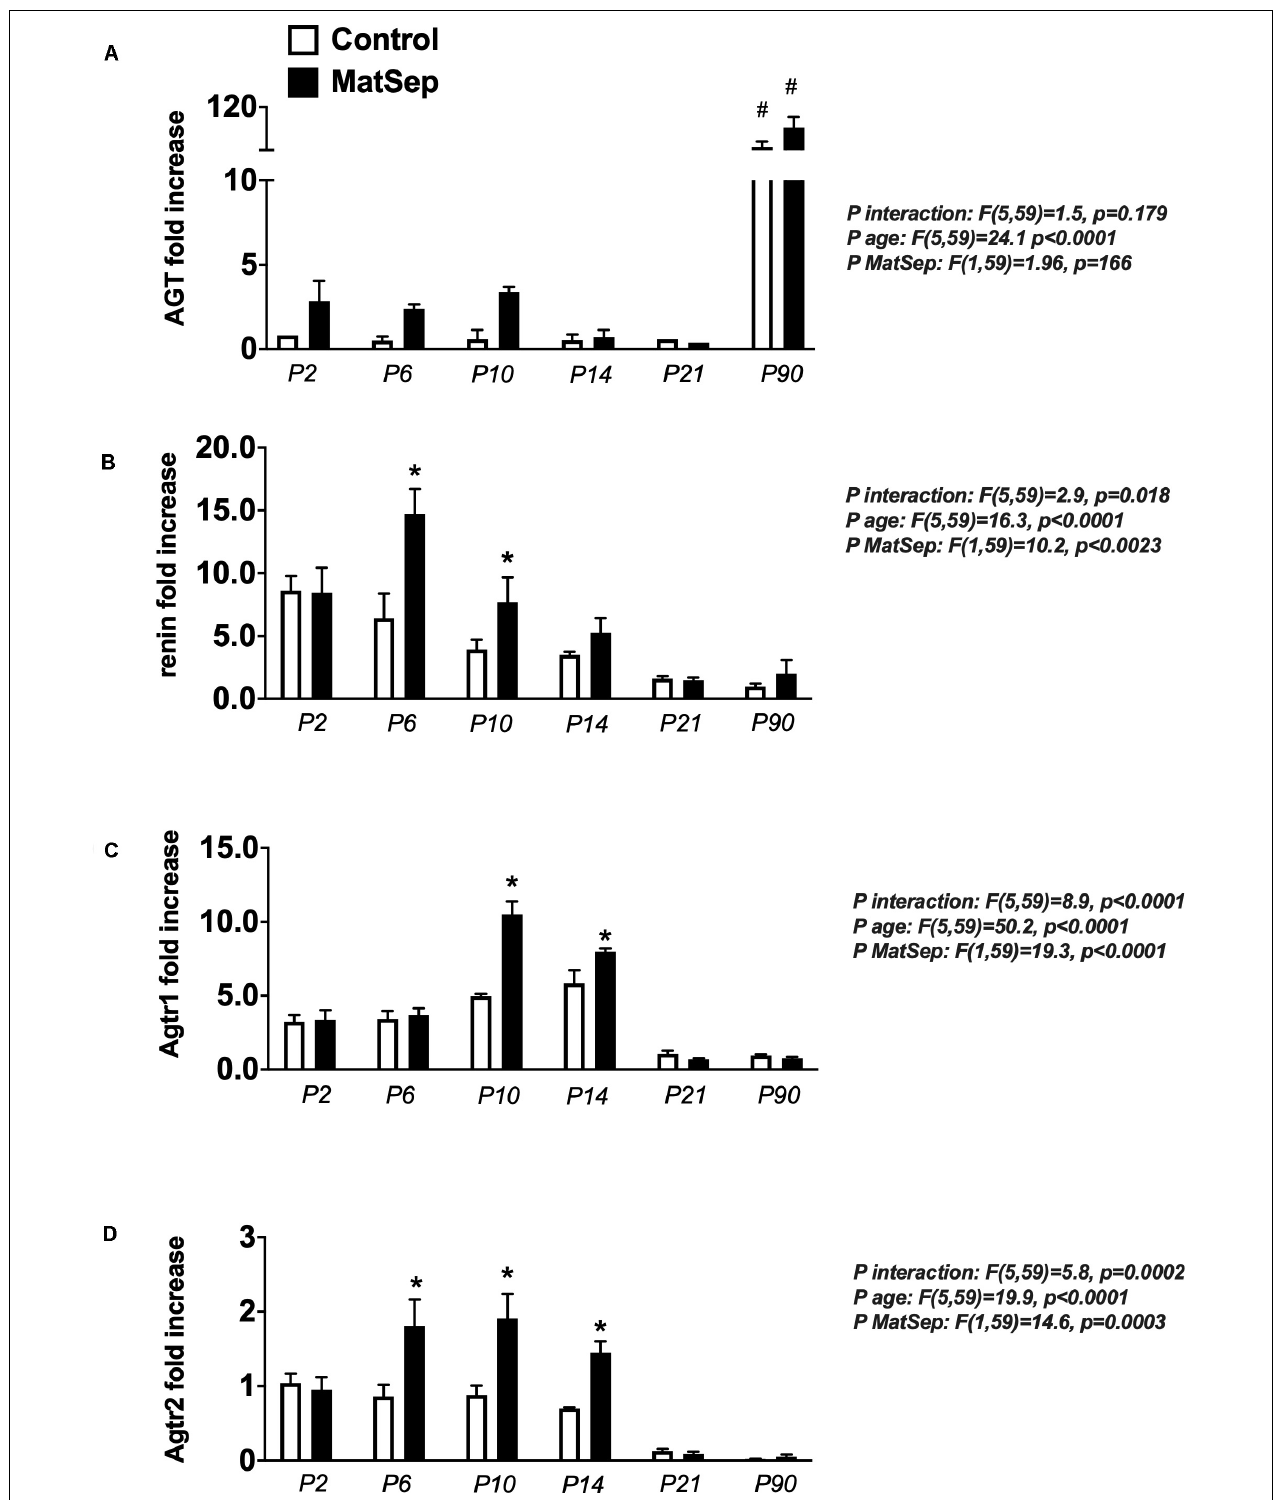
FIGURE 4 | Effect of maternal separation (MatSep) on intrarenal RAS mRNA expression trajectory from P2 to P90: (A) Angiotensinogen (Agt), (B) renin, (C) angiotensin type 1 receptor (Agtr1) and (D) angiotensin type 1 receptor (Agtr2). Each RAS component was normalized to Agtr2 receptor control levels at P2. # p < 0 . 05 vs. P2–P21, * p < 0.05 vs. C. n = 6–8 per group.